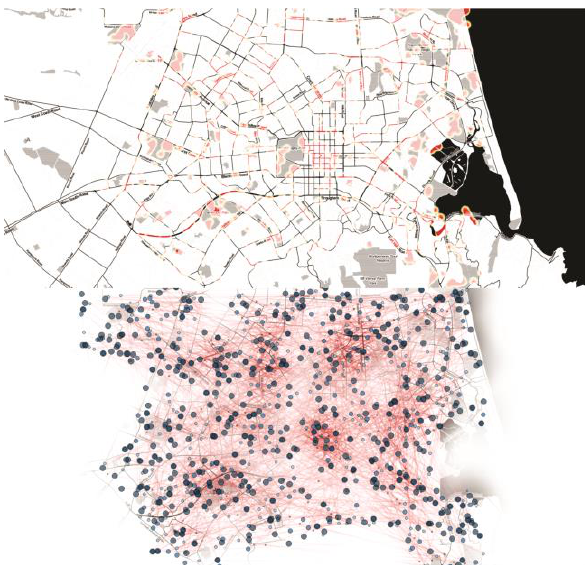
Figure 6. Spatial pattern of activities tracked by volunteers (top - red areas indicate more frequently visited areas of the city). Individual tracks and usage of smart medical devices